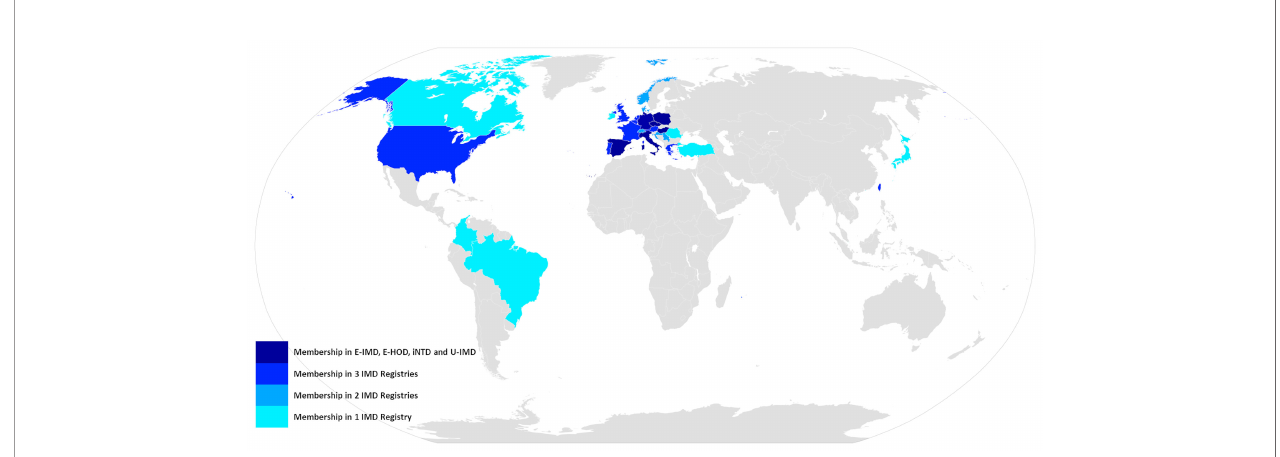
FIGURE 2 | Global outreach of the E-IMD, E-HOD, iNTD and